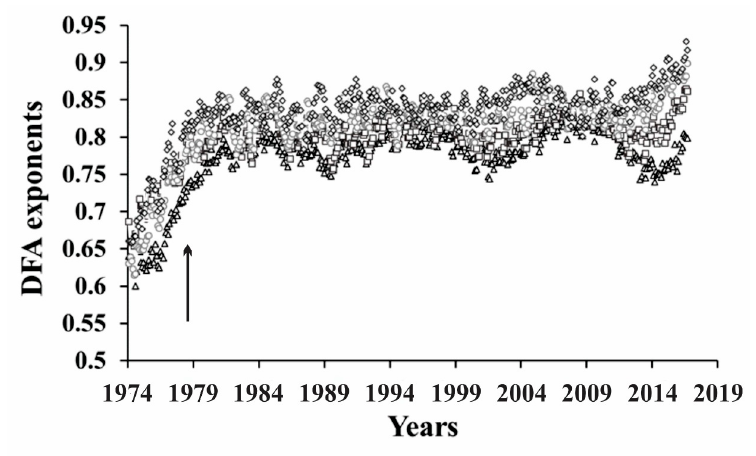
Figure 7. DFA exponents of waiting times sequences (M2.2 threshold) around the Enguri reservoir (100 km) 1974–2017. Polynomial fit from 2 to 5. (Triangles p = 2, squares p = 3, circles p = 4, diamonds p = 5). Arrow marks the beginning of lake recharge; long-range correlation increases after